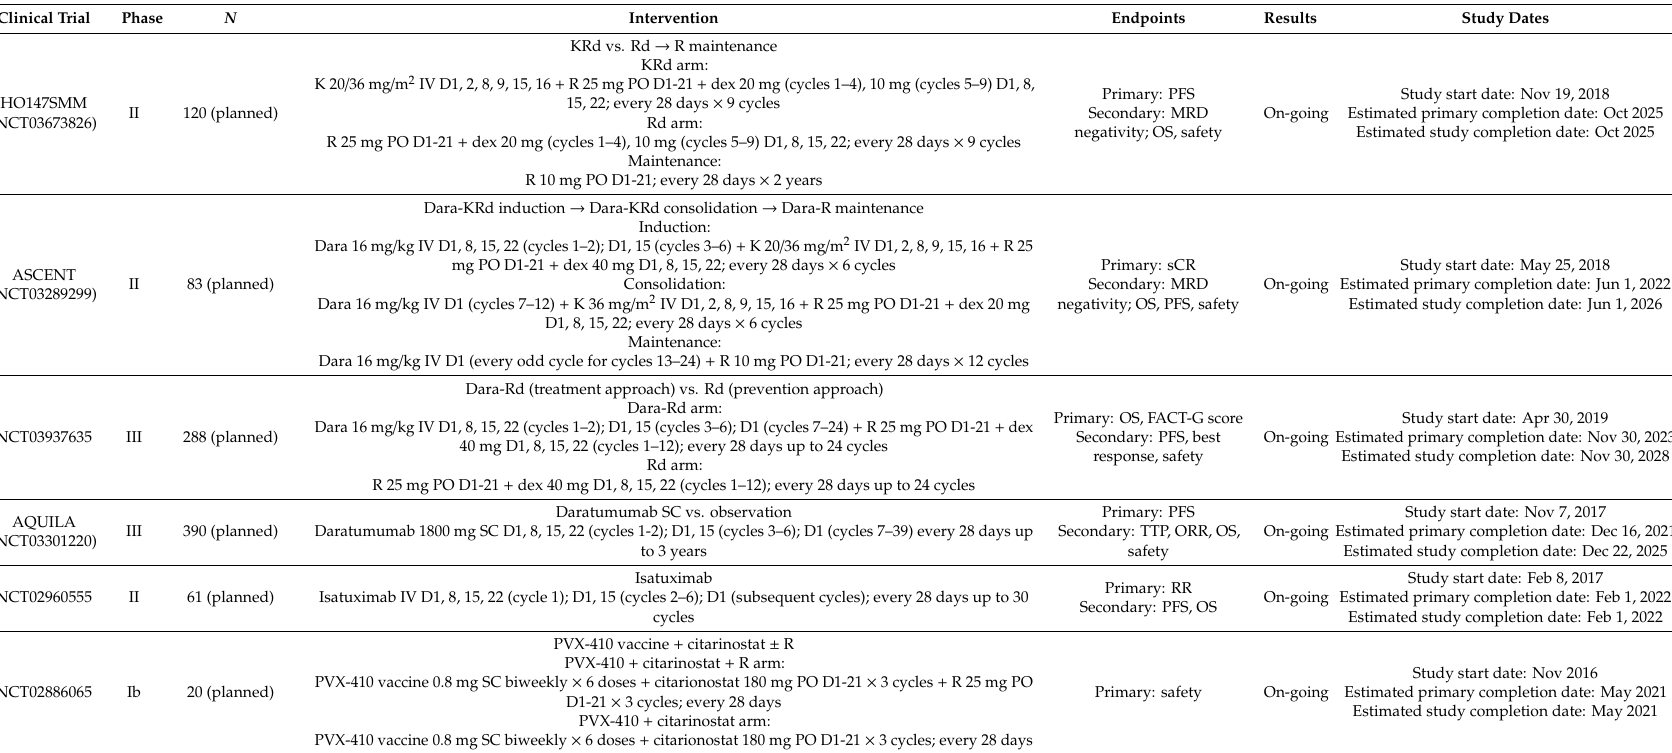
ASCT = autologous stem cell transplantation; D = day; Dara = daratumumab; dex, d = dexamethasone; FACT-G = functional assessment of cancer therapy-general; K = carfilzomib; R = lenalidomide; MRD = minimal residual disease; ORR = overall response rate; OS = overall survival; PFS = progression free survival; RR = response rate; sCR = stringent complete response; TTP = time to